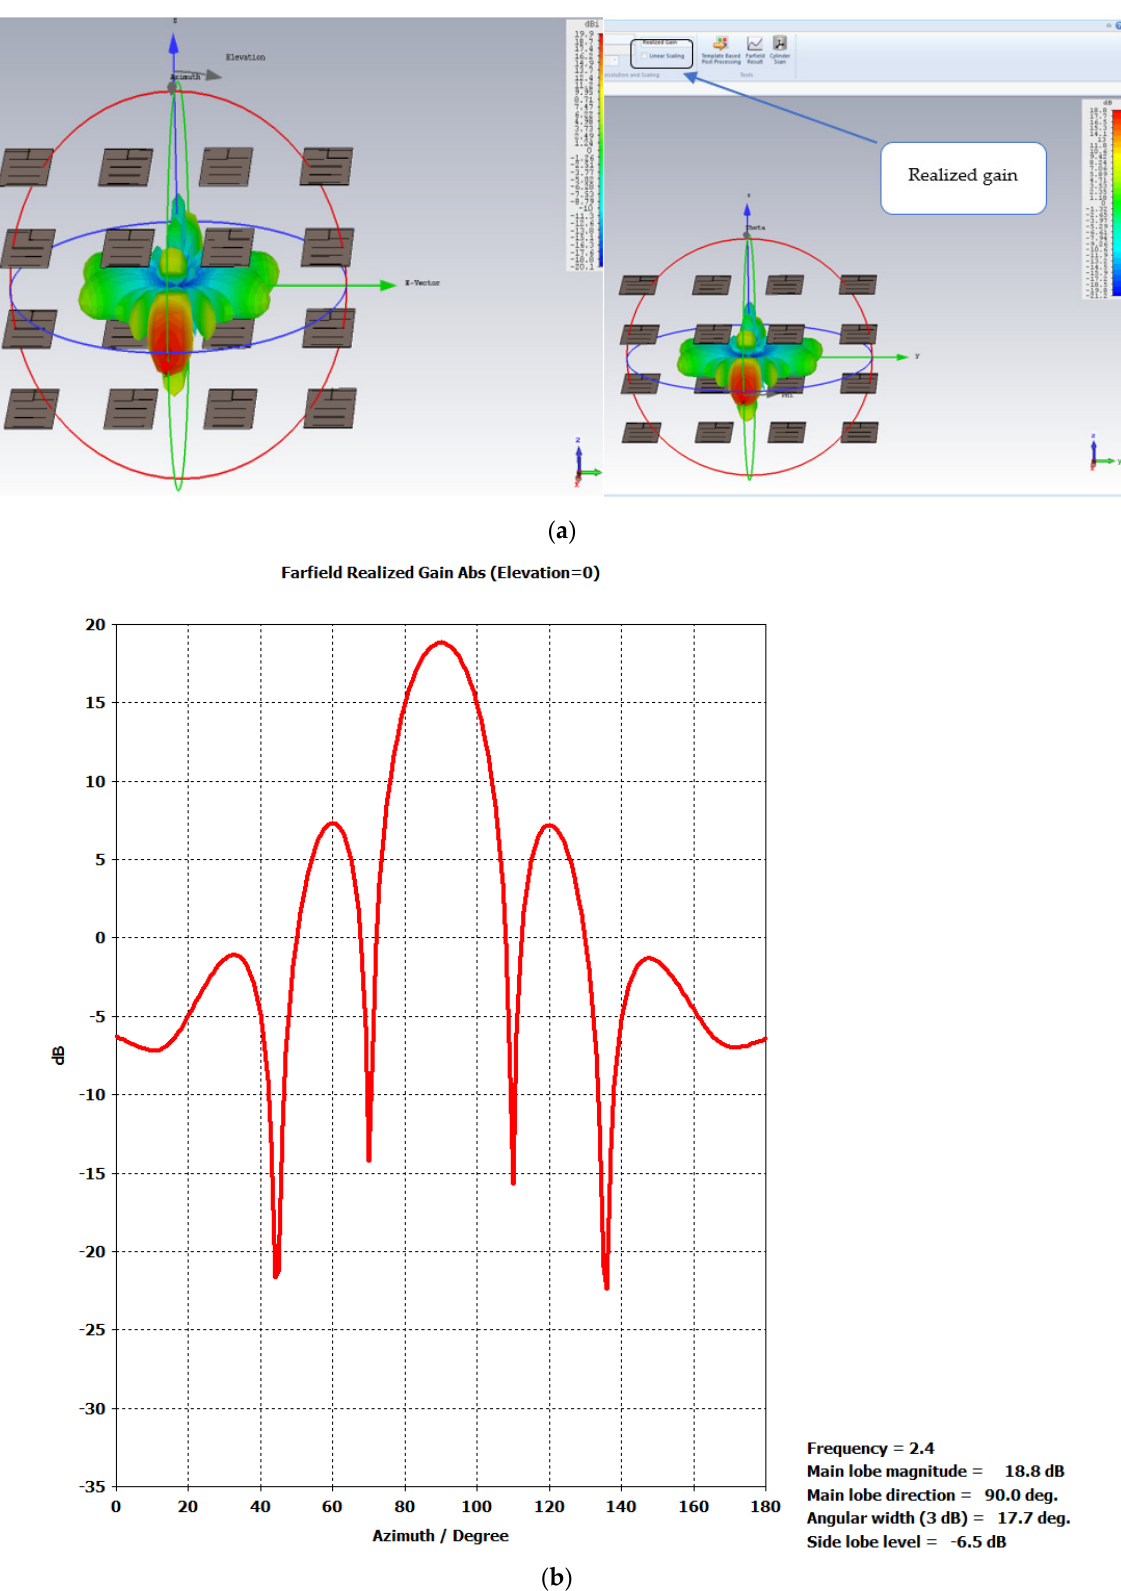
Figure 14. ( a ) Array of 4 × 4 Yagi–Uda elements—Top view; ( b ) Element pattern within an array of 4 × 4 Yagi-Uda elements—Back view; ( c ) Element pattern within an array of 4 × 4 Yagi-Uda ele- ments—Front view; ( d ) Element pattern inside an array of 4 × 4 Yagi-Uda element—Top mesh view .